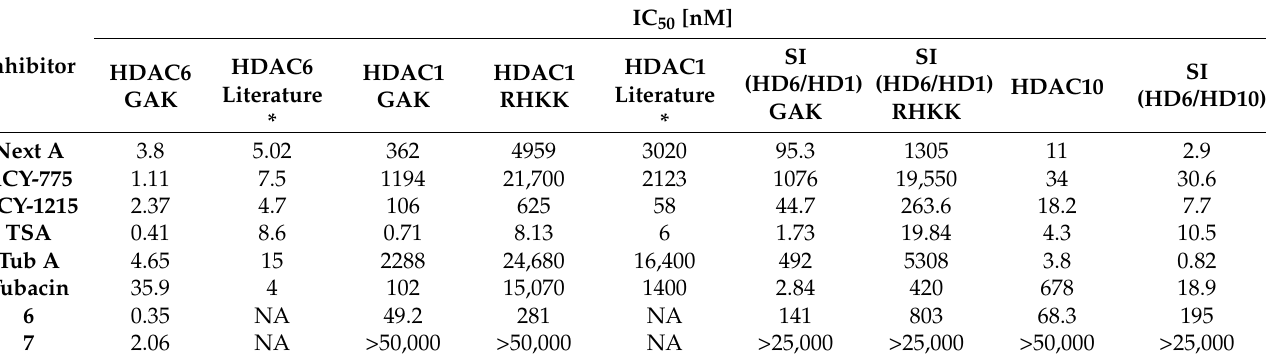
Table 1. Selectivity of HDAC6is determined in vitro using purified human